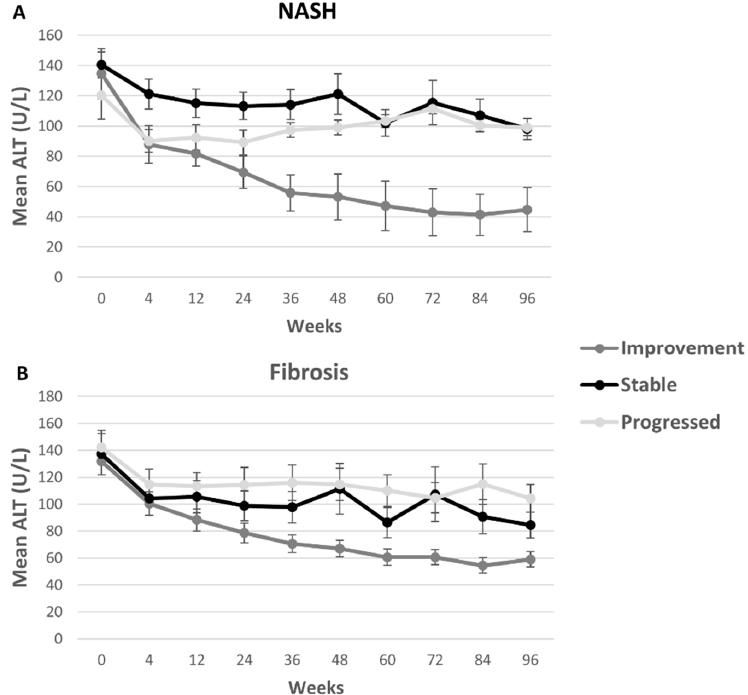
Figure 1. Mean ALT concentrations were higher among stable and progressing groups than among improving participants, when measured by the NASH assessment. Mean ALT concentrations had similar initial trajectories when measured by the fibrosis score, with the improvement group dropping approximately 45%. Mean ALT is shown at each time point for participants that showed progression (lightest gray), improvement (dark gray) and that stayed stable from baseline to 96 weeks (black) for NASH assessments ( A ) and for fibrosis ( B ). ALT: alanine aminotransferase; NASH: nonalcoholic